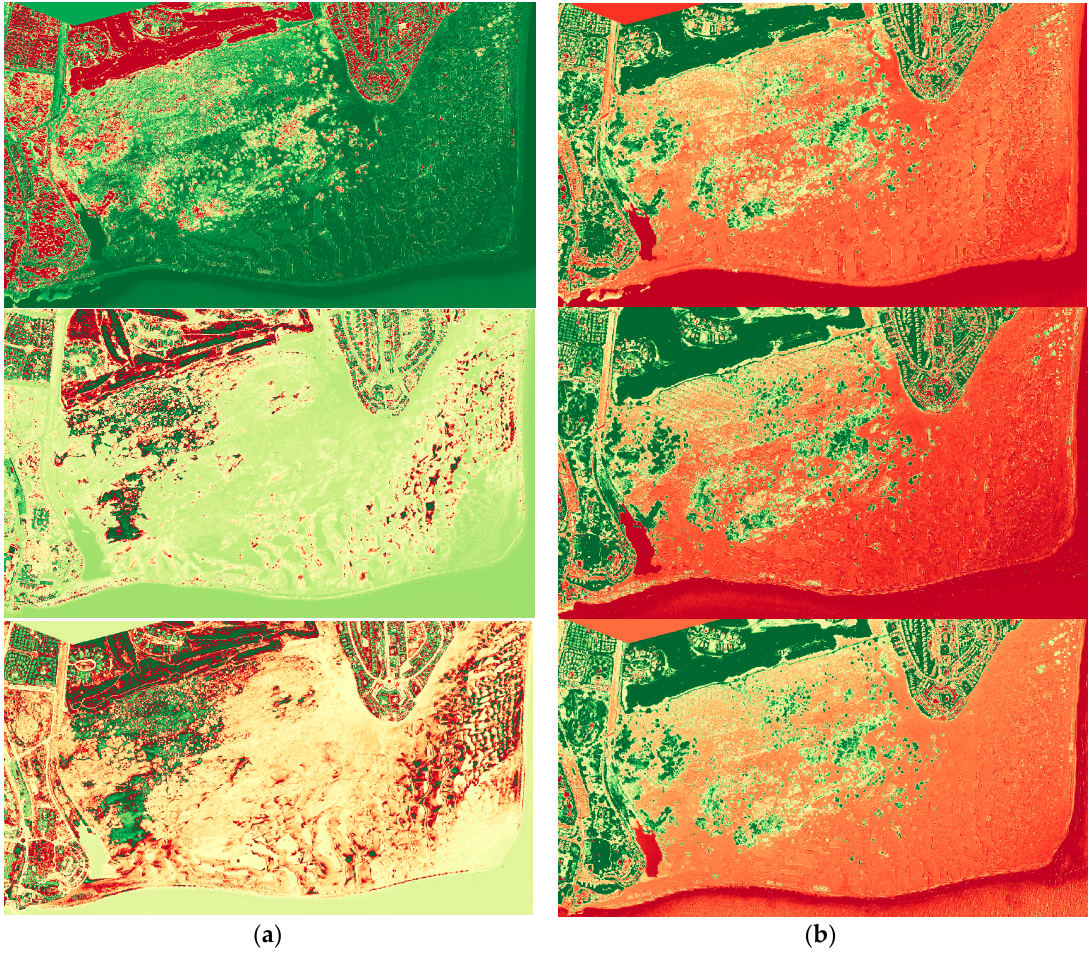
Figure 9. Enhanced Vegetation Index for three WV-2 subscenes of Maspalomas (17 January 2013, 11 August 2013 and 4 June 2015): ( a ) without atmospheric correction; ( b ) after the 6S correction.